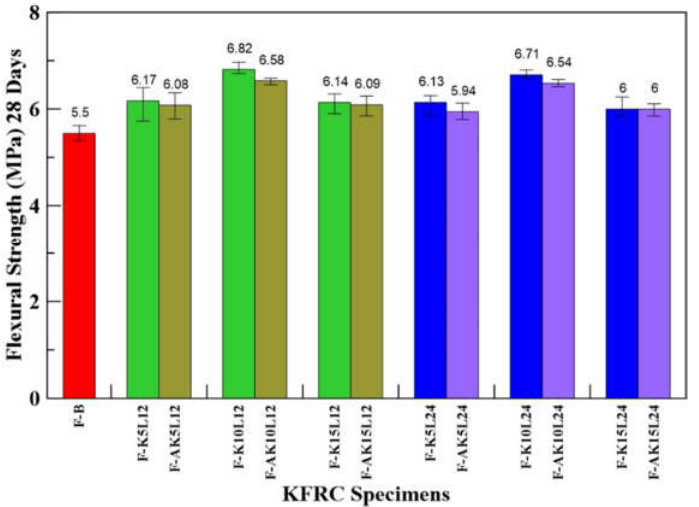
Figure 7. Flexural strengths of the benchmark and KFRC specimens under various weight percent-